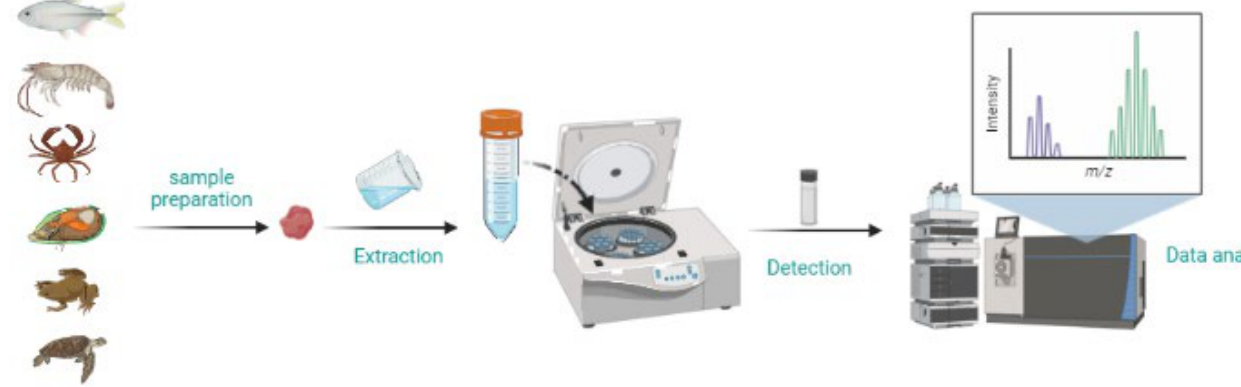
Figure 1. The schematic diagram of the proposed